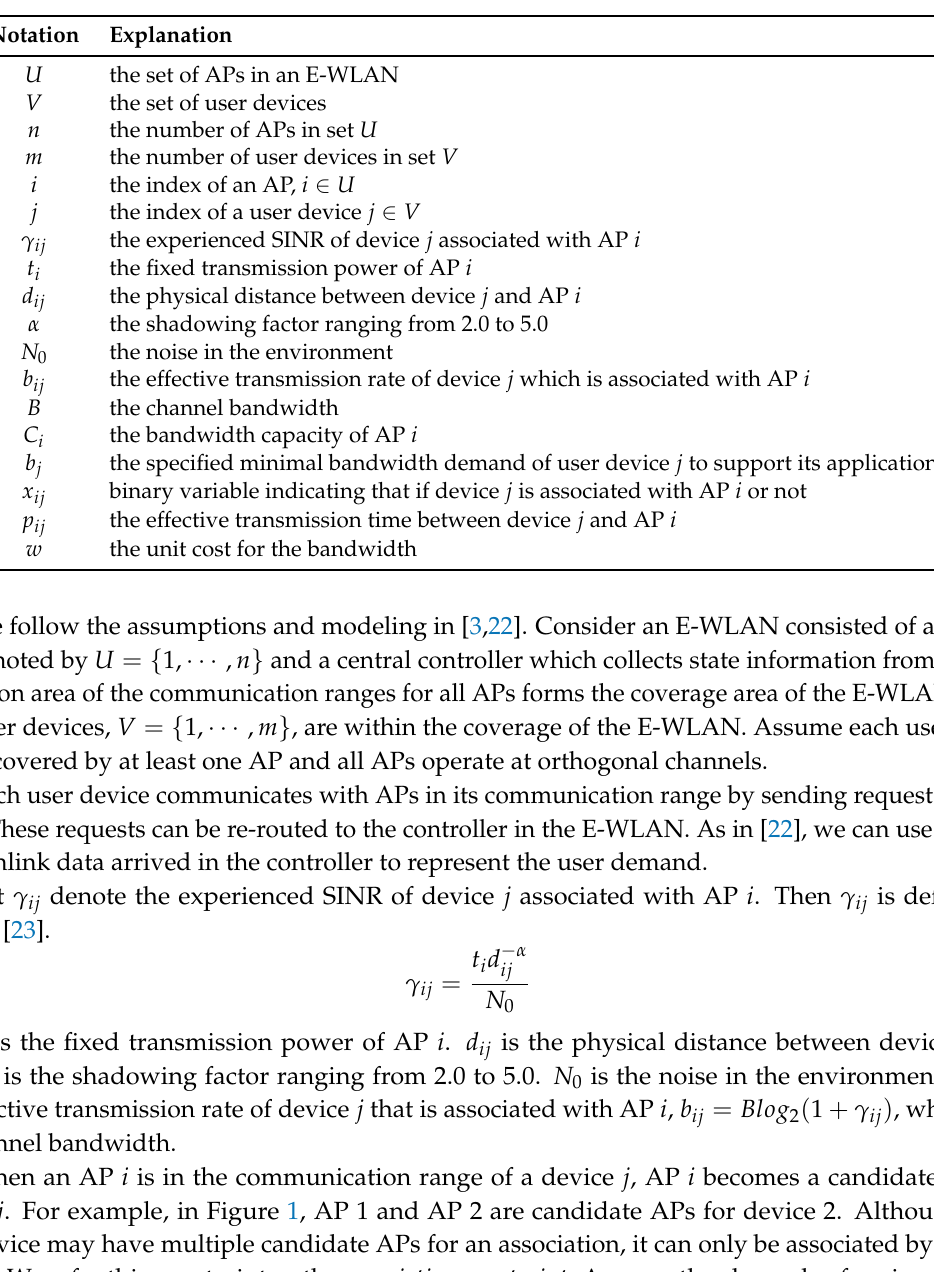
Table 1. Notations Used.